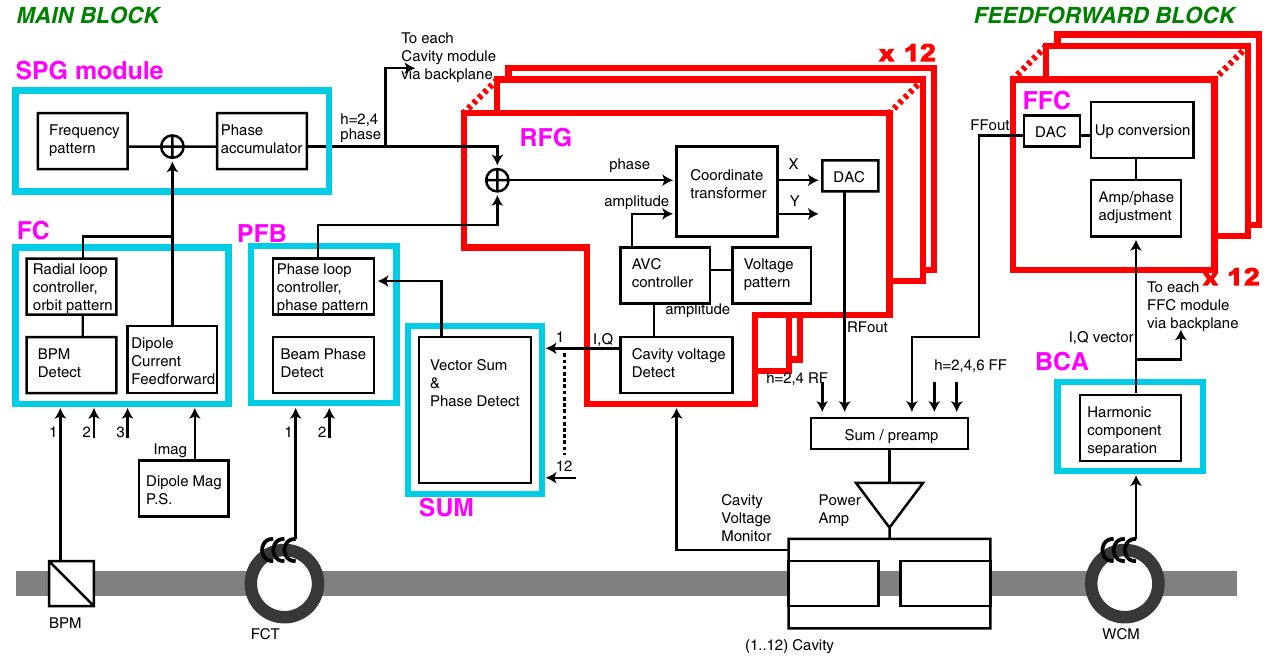
FIG. 4. (Color) Simplified block diagram of the LLRF system of the RCS. Red: for each system; blue: one for whole